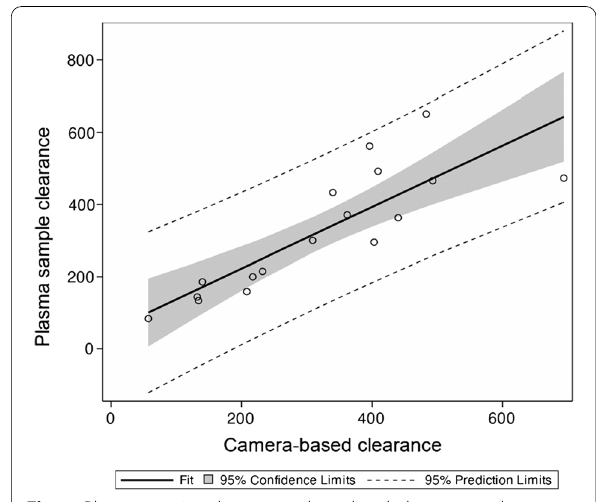
Fig. 5 Plot comparing the camera-based and plasma sample clearances of NTA (mL/min/1.73 m 2 ). The intercept is 52 (95% confidence intervals of 50 to 154) and the slope is 0.85 (95% − confidence intervals of